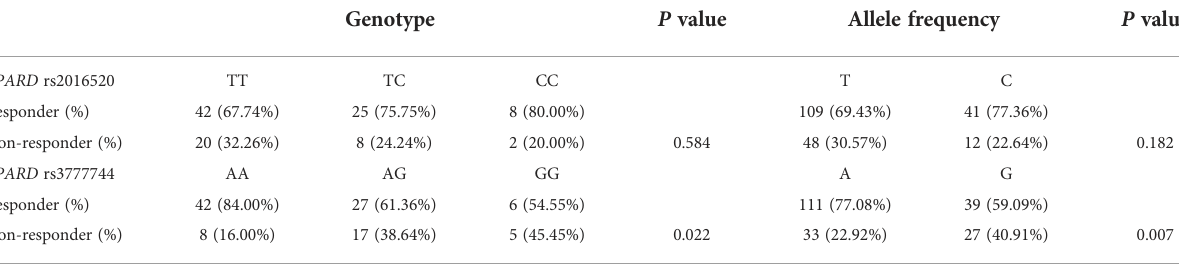
TABLE 4 Genotype and allele distributions between responders and non-responders of PPARD rs2016520 and rs3777744 variants (n = 105). Genotype P value Allele frequency P